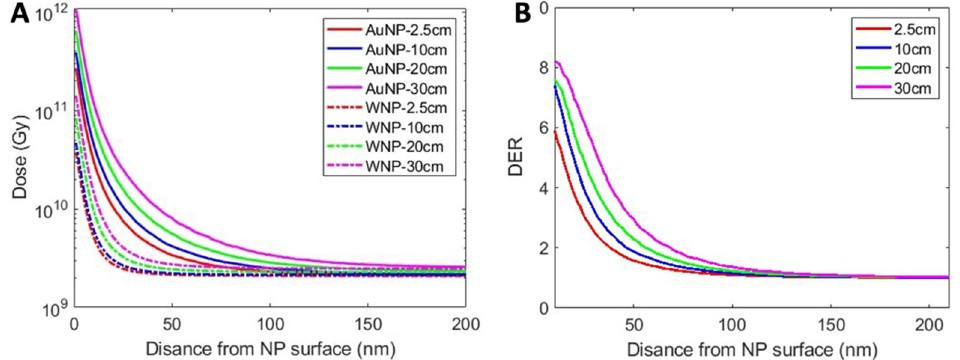
Figure 8. ( A ) Dose as a function of radial distance for both AuNPs and WNPs. ( B ) Dose enhancement ratio (DER) as a function of radial distance.